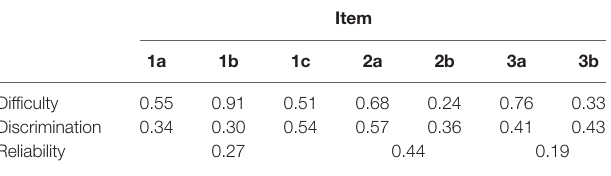
Table 2 | Item characteristics for the multiple-choice-equivalent